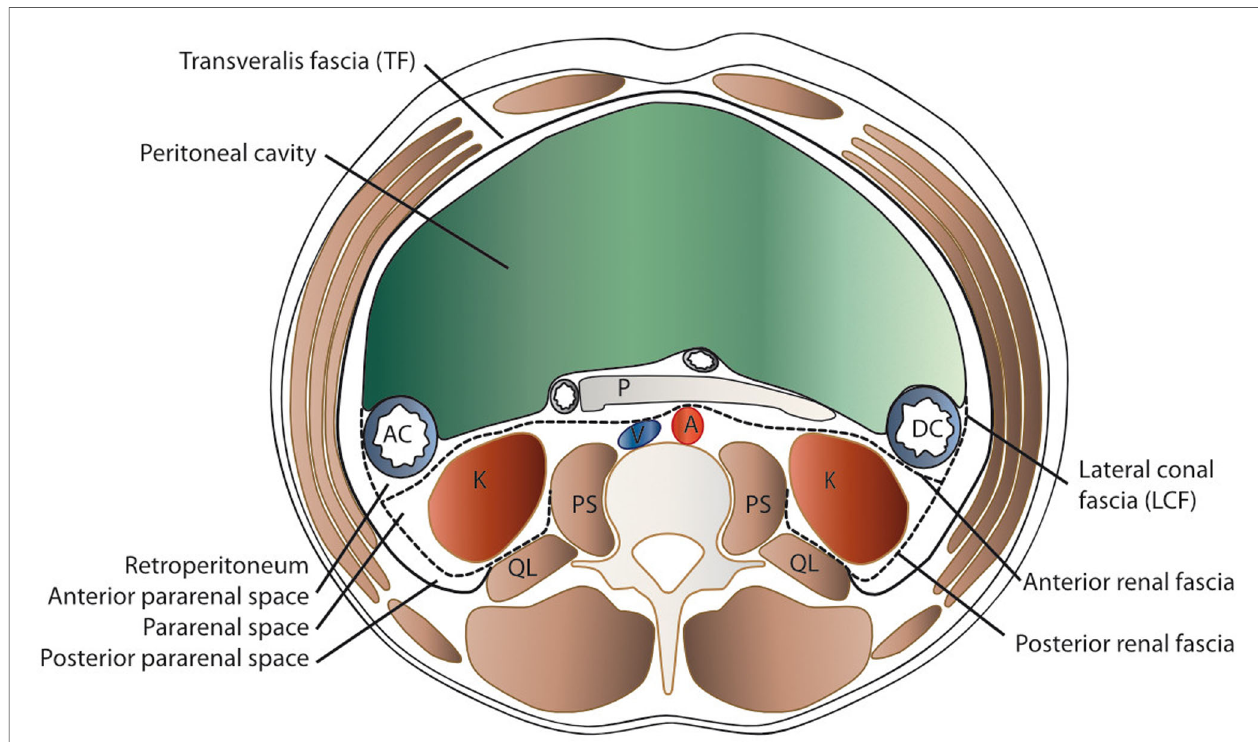
FIGURE 1 | Schematic transverse section of the abdomen with emphasis on the extraperitoneal spaces. The abdominal structures are separated from the musculoskeletal structures by the transversalis fascia (TF). The peritoneal cavity is delimited by the parietal peritoneum, which is the anterior border of the anterior pararenal space (APS) that contains the ascending (AC) and descending (DC) colon, pancreas (P), and duodenum (D). Posteriorly lies the perirenal space (PRS) with the kidney (K) and medially the aorta (A) and vena cava (V), delimited by the anterior renal fascia (anterior RF or Gerota ’ s fascia) and the posterior renal fascia (posterior RF or Zuckerkandl ’ s) and laterally the lateroconal fascia (LCF). Dorsally, the quadratus lumborum (QL) and psoas major (PS) muscles are found within the